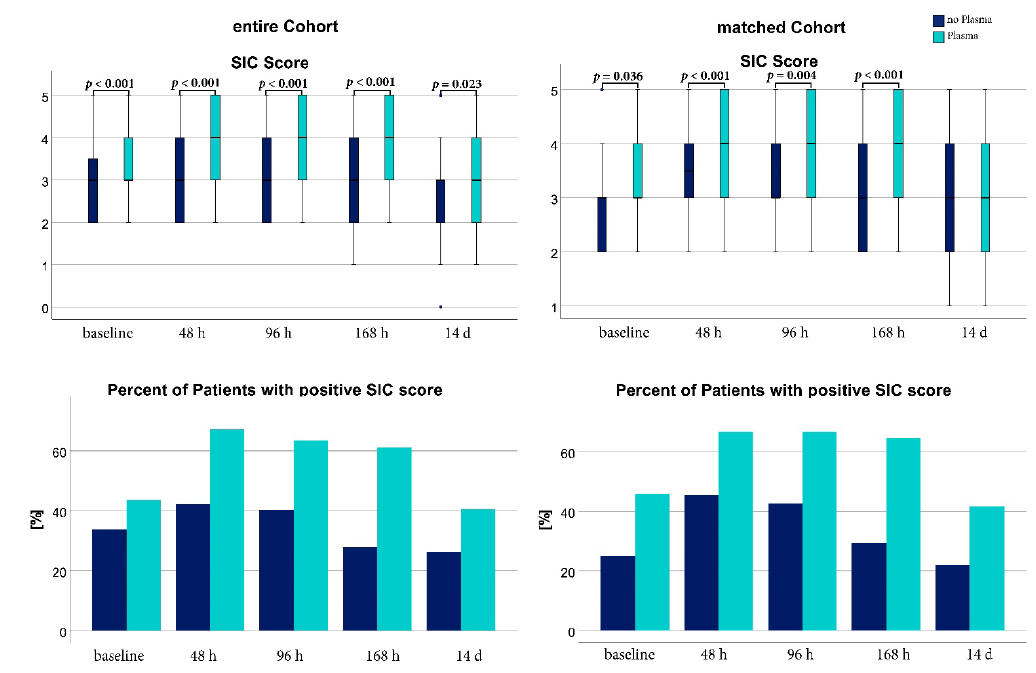
Figure 1. Sepsis-Induced Coagulopathy (SIC) score at different points in time of the matched and the unmatched cohort. Boxplots show the SIC Score for patients who received Plasma (cyan) or no plasma (dark blue) of the matched cohort and unmatched cohort. A Mann-Whitney-U test was used or comparison. The bottom graphics show the relative frequency of patients meeting the cut-off of four or more points in the SIC Score. [%]: percent; [h]: hours; [d]: days.